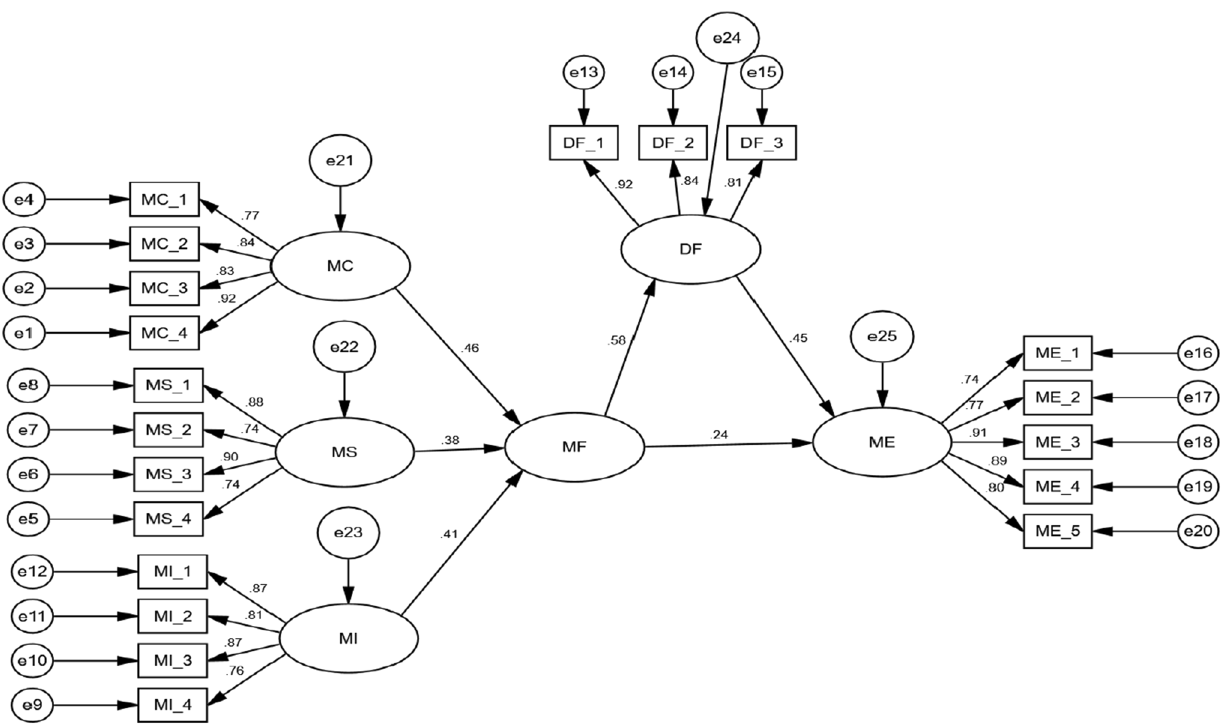
Fig. 3 Structural model Table 6 Testing direct relationship